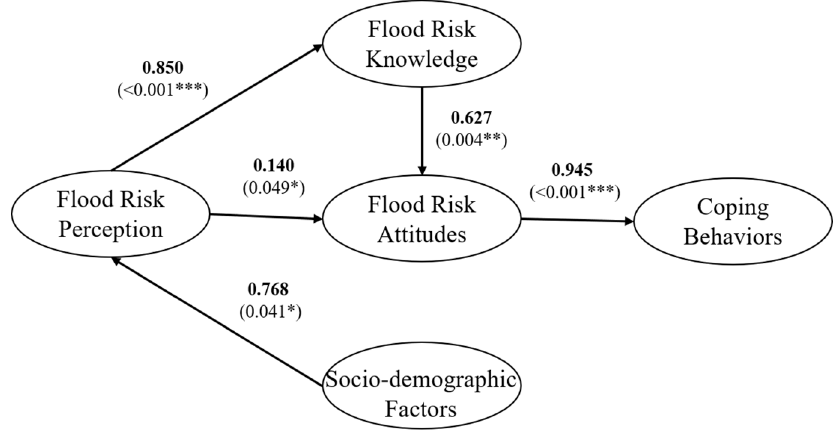
Figure 5. Affect path to protective coping behaviors. Note: * p < 0.05, ** p < 0.01, *** p < 0.001.